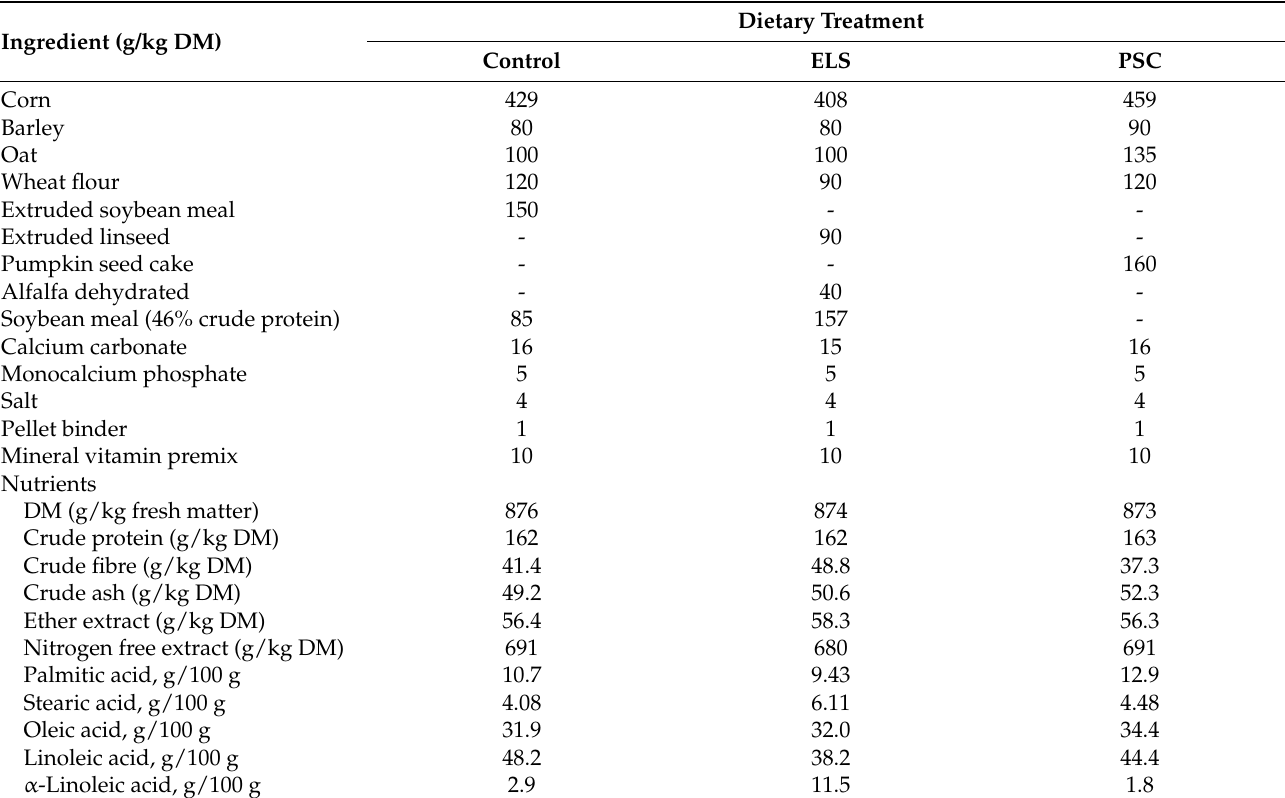
Table 1. Ingredient and nutrient composition of control, extruded linseed (ELS), and pumpkin seed cake (PSC) experimental